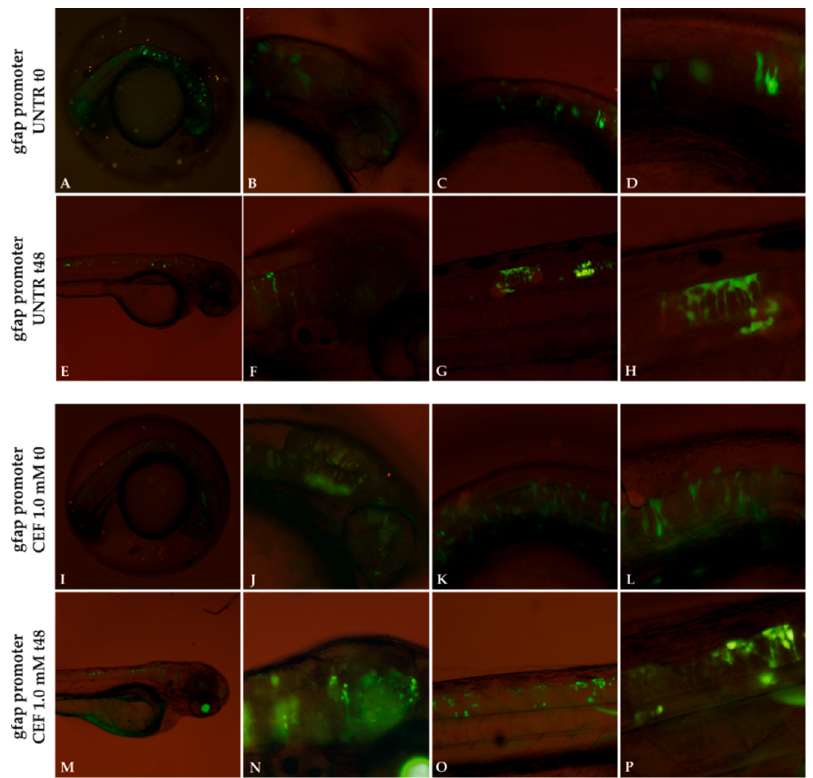
Figure 8. E ff ect of 1.0 mM CEF treatment on gfap promoter. Untreated (UNTR) embryos expressing gfap promoter as filamentous structures ( A – H ) at 24 and 72 hpf, respectively. CEF e ff ects on embryos at t0 (24 hpf) ( I – L ) and after 48h of treatments ( M – P ). Magnification: 4 × ( A , E , I , M ); 10 × ( B , C , F , G , J , K , N , O ); 20 × ( D , H , L , P